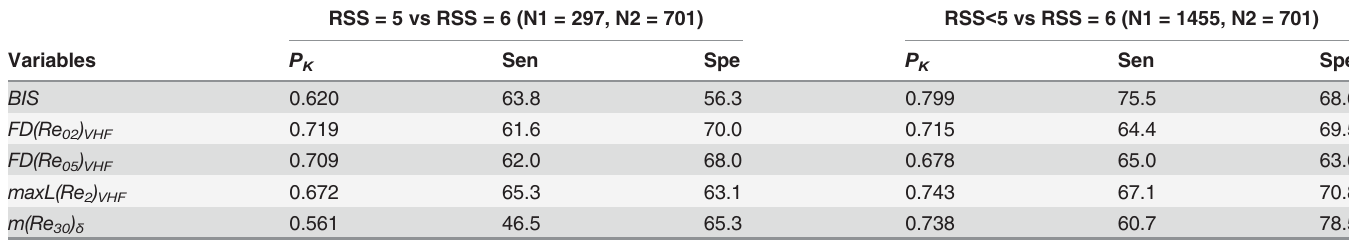
Table 2. RSS assessment: trial 1 and 2.